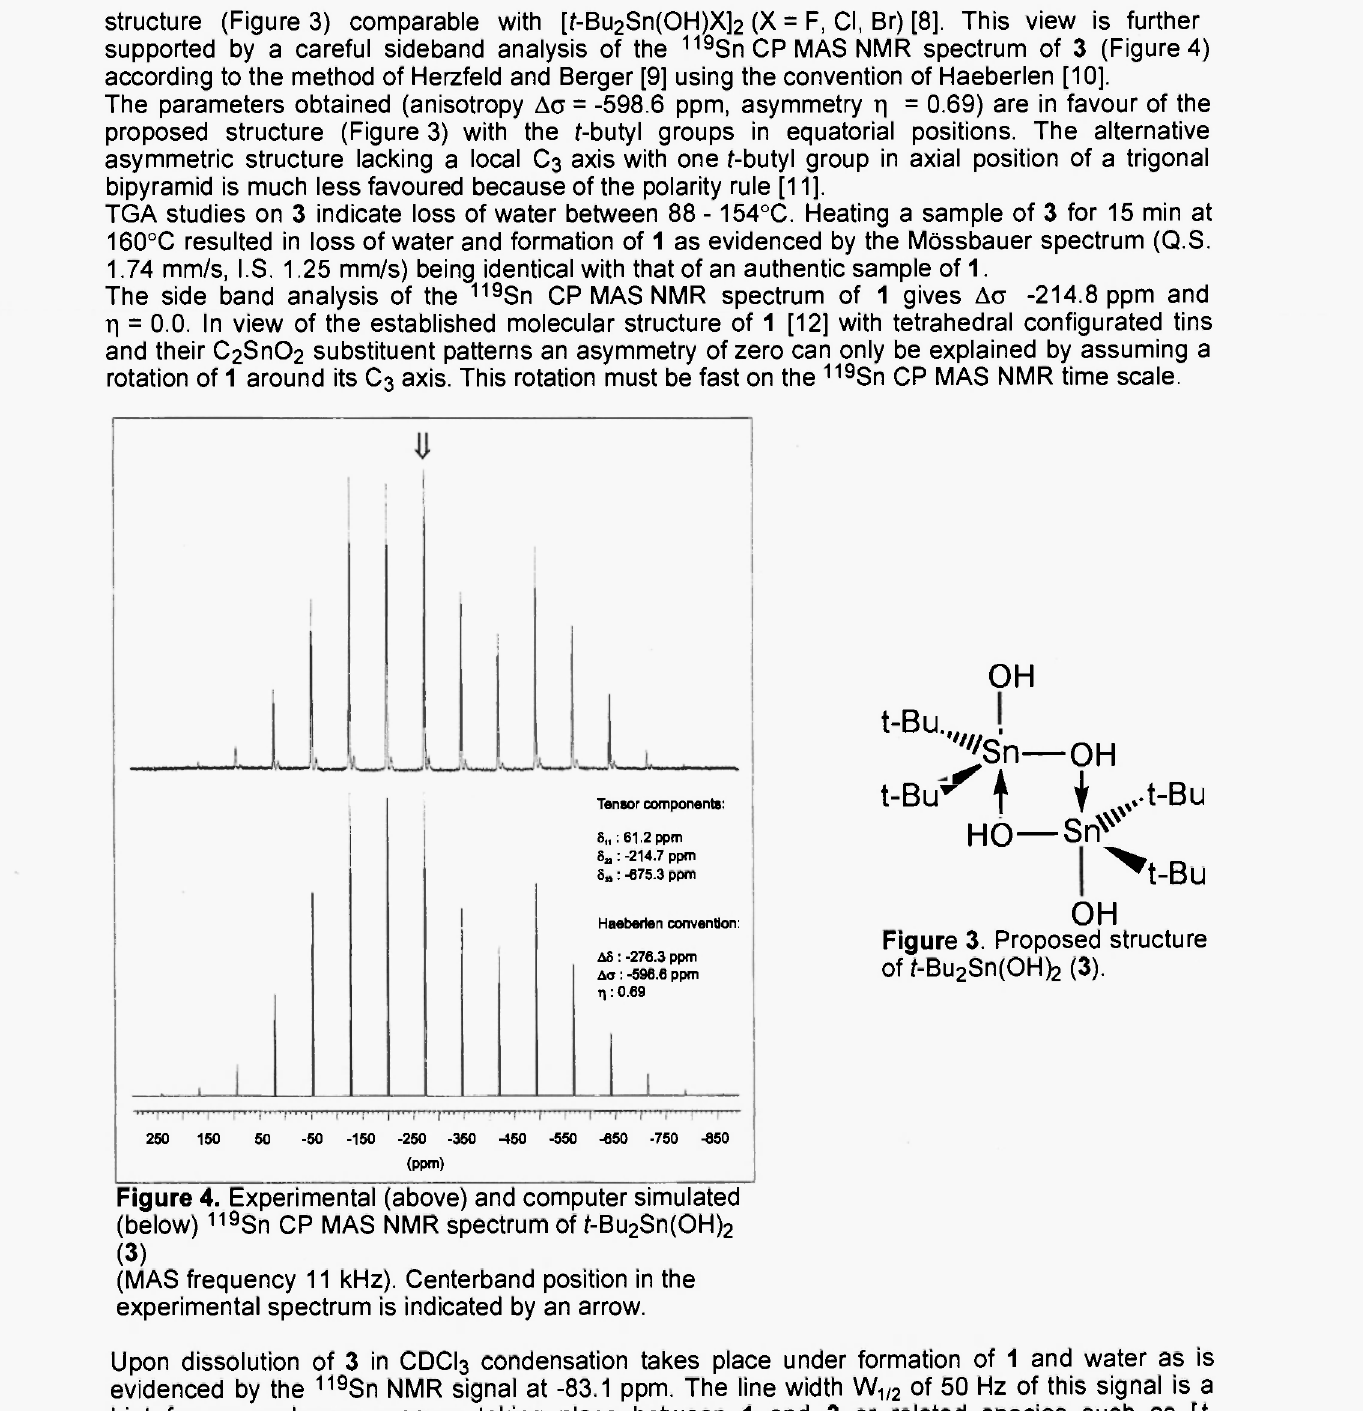
Figure 4. Experimental (above) and computer simulated (below) 119 Sn CP MAS NMR spectrum of f-Bu 2 Sn(OH) 2 (3) (MAS frequency 11 kHz). Centerband position in the experimental spectrum is indicated by an